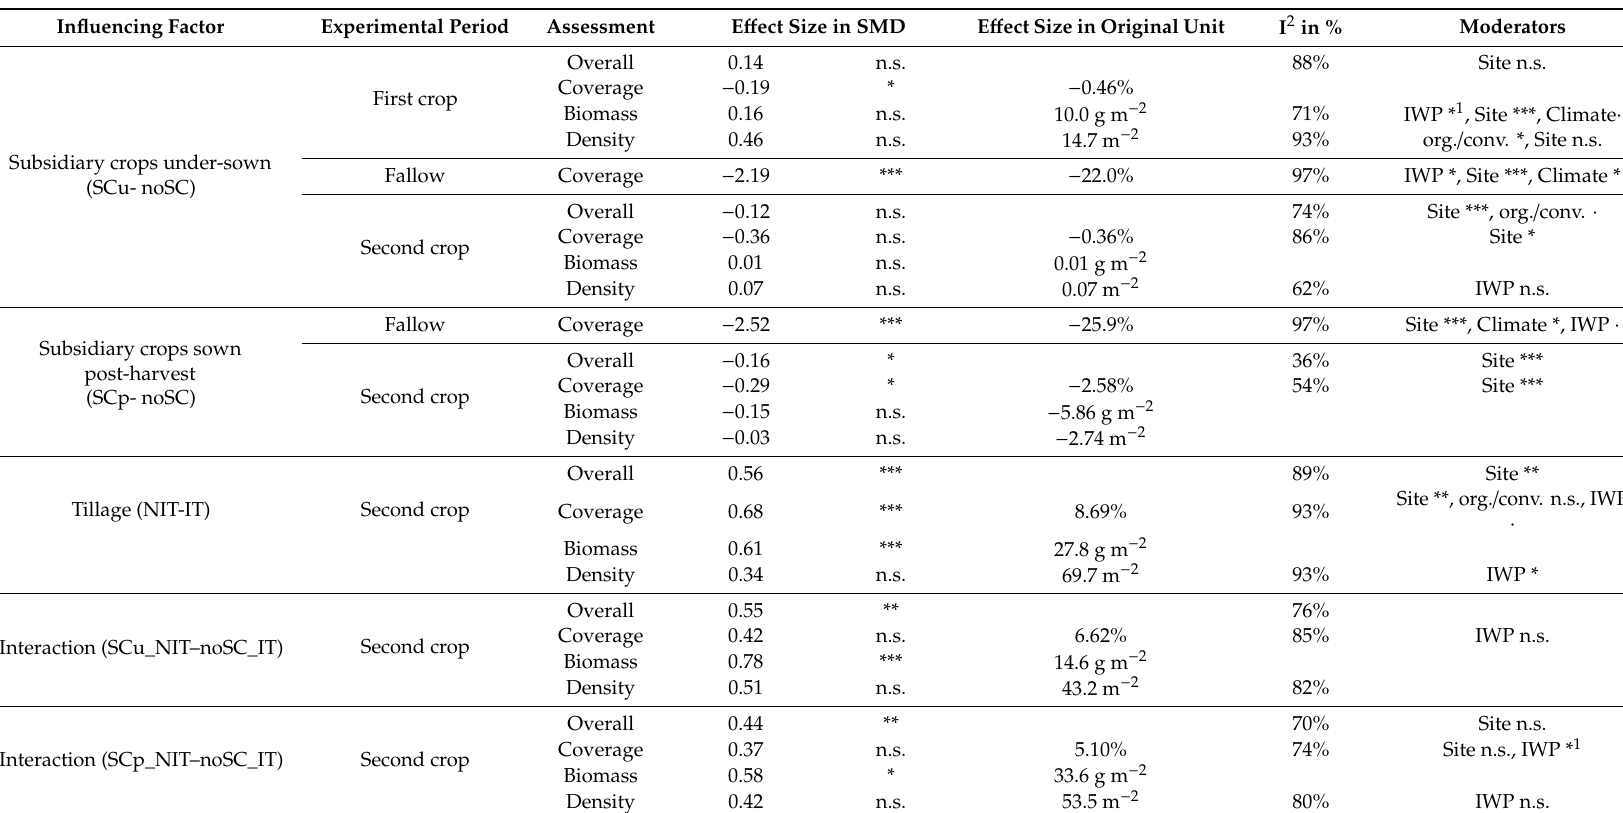
Table 3. Summary of the e ff ects of subsidiary crops (SCs) and tillage expressed as standardized mean di ff erence (SMD) and in the original unit. They were combined in a system with SCs and non-inversion tillage (SCu_NIT / SCp_NIT) as an alternative system or no SCs and inversion tillage (noSC_IT) as the reference system. The e ff ect was measured on weed ground coverage, biomass, density, and over all of the three assessments throughout three experimental periods. Negative e ff ect sizes represent a lower weed abundance in SCs, non-inversion tillage or the alternative. The original unit for weed coverage is percentage ground coverage, for weed biomass g m − 2 and for weed density plants m − 2 . The heterogeneity is represented by I 2 . All moderators with an R 2 > 10% are listed. All significant results are printed in bold font: significance code: n.s. > 0.10; · < 0.10; * < 0.05; ** < 0.01; *** < 0.001. A detailed list of all SMD for each experiment can be found in Table